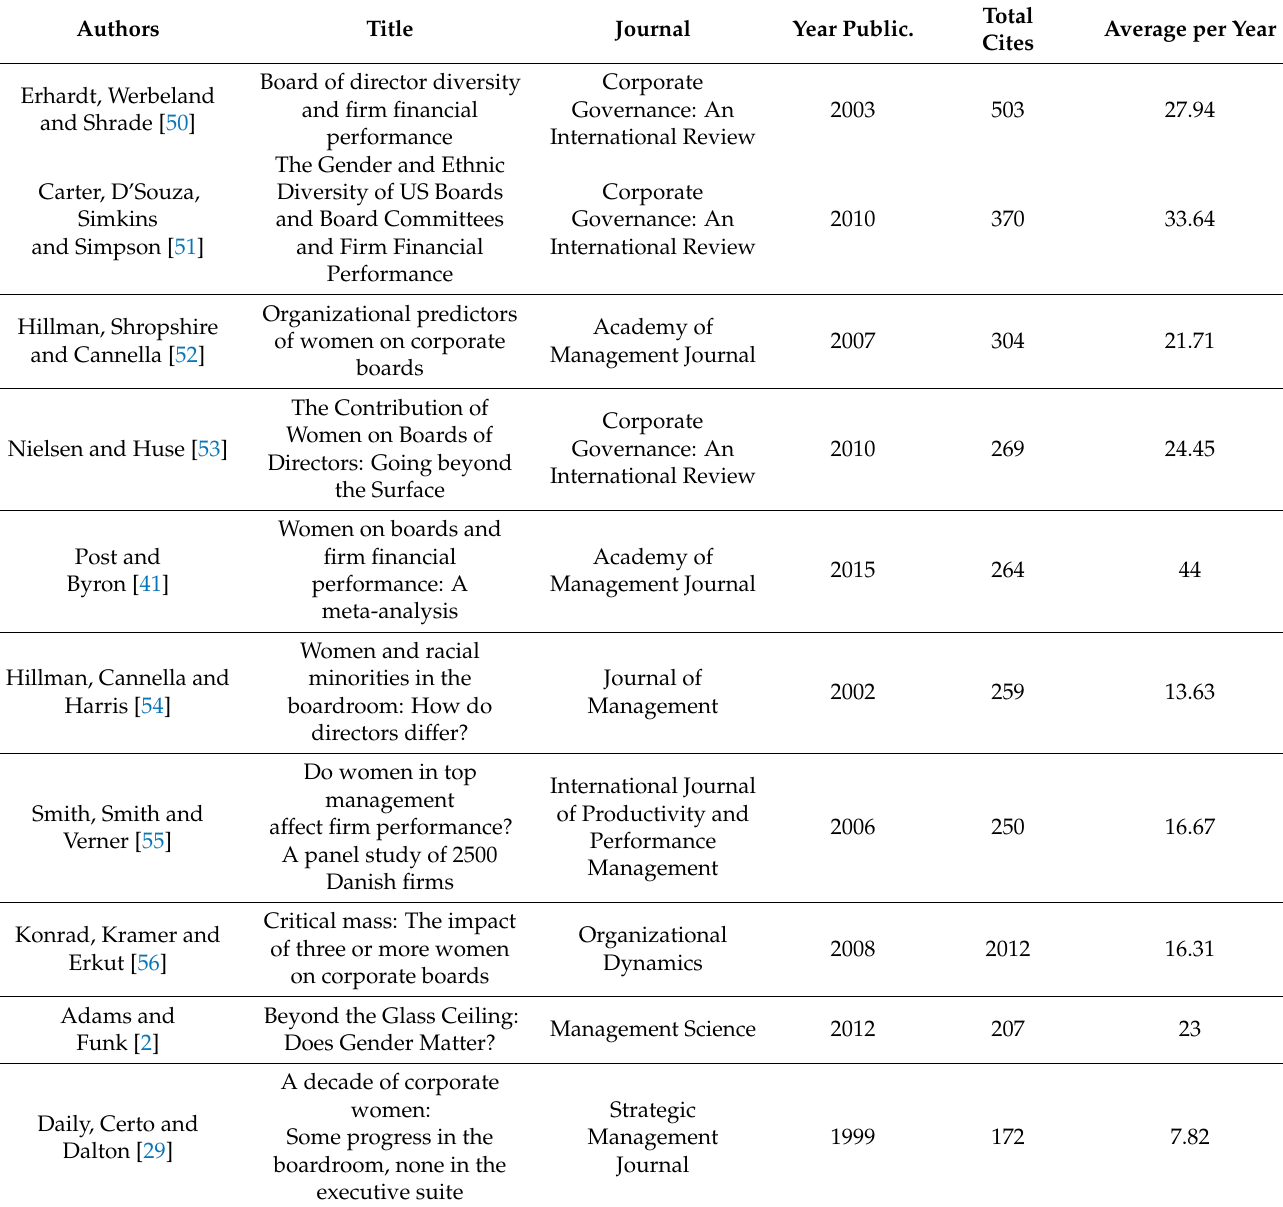
Table 1. The 10th most cited